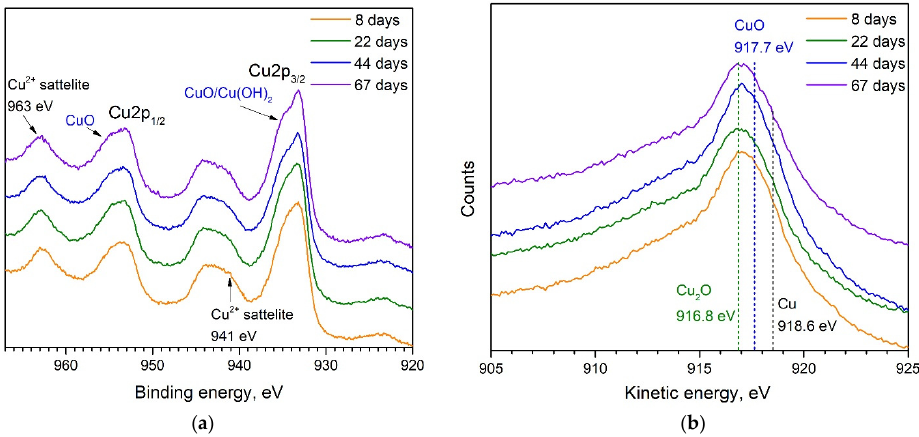
Figure 4. Time evolution of ( a ) XPS and ( b ) AES spectra of UV-ozone treated Cu NPs, which are then kept in ambient conditions. Indications of different characteristic peaks are the same as in Figure 3.